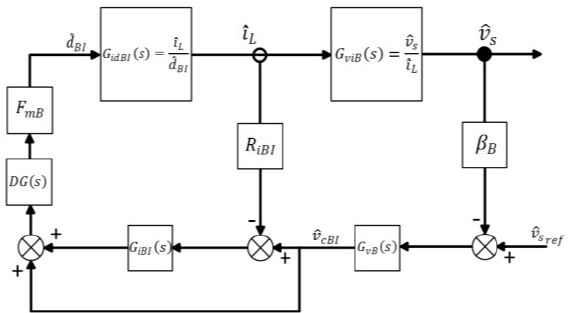
Figure 3. Block diagram in Island mode.